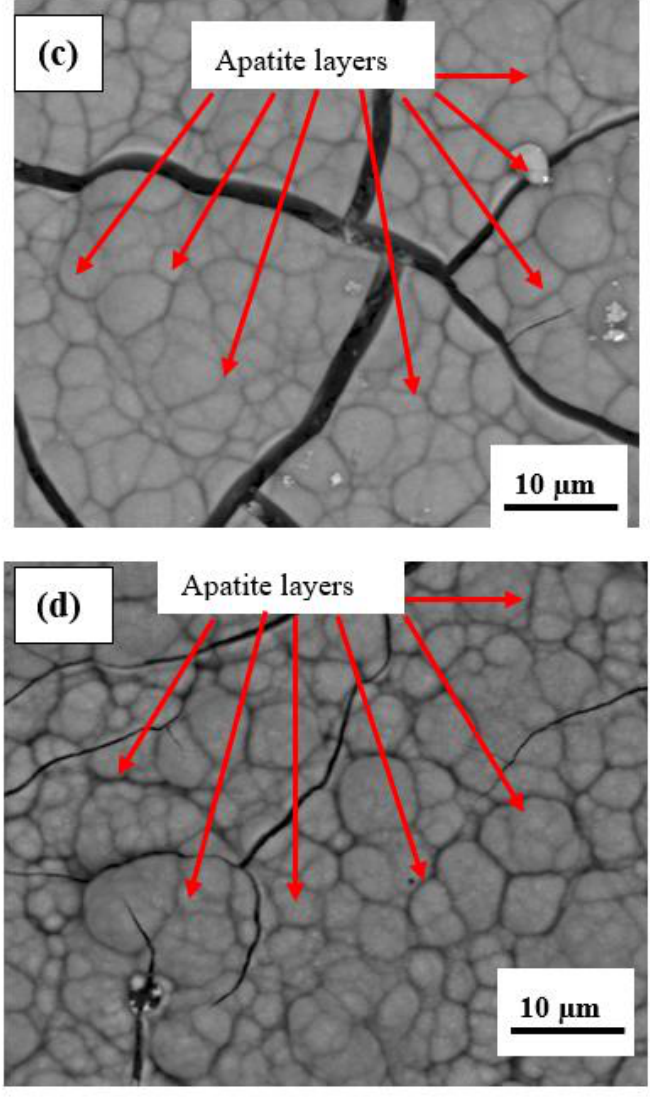
Figure 10. SEM micrographs of plasma-sprayed FsHA with ( a ) 0 wt.% YSZ, ( b ) 10 wt.% YSZ, ( c ) 15 wt.% YSZ, and ( d ) 20 wt.% YSZ coatings on the Ti – 6Al – 4V substrate after 14 days of immersion in SBF.